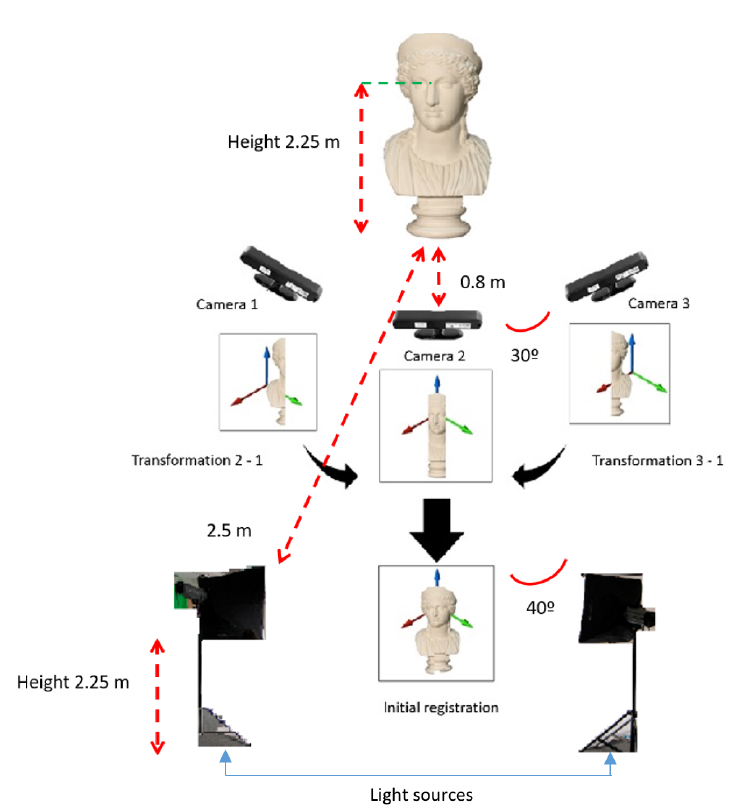
Figure 5. Graphical detailing of the procedure followed to reconstruct the 3D models upon the depth and RGB information captured by the three RGB–D